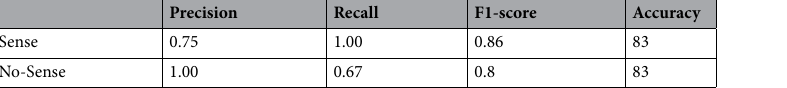
Precision Recall